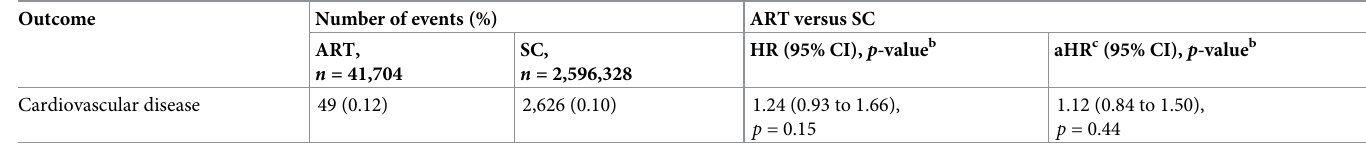
Table 4. Analysis of cardiovascular disease a in children born after ART and SC between 1996 and 2005.